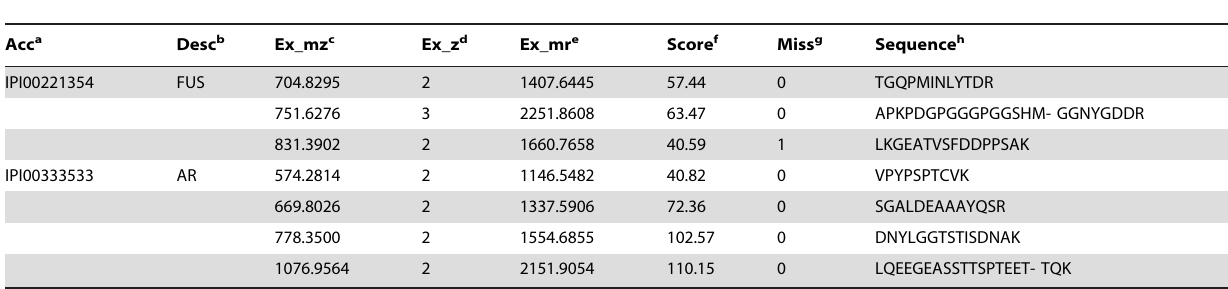
Table 1. Analysis of mass spectrometric data for FUS and